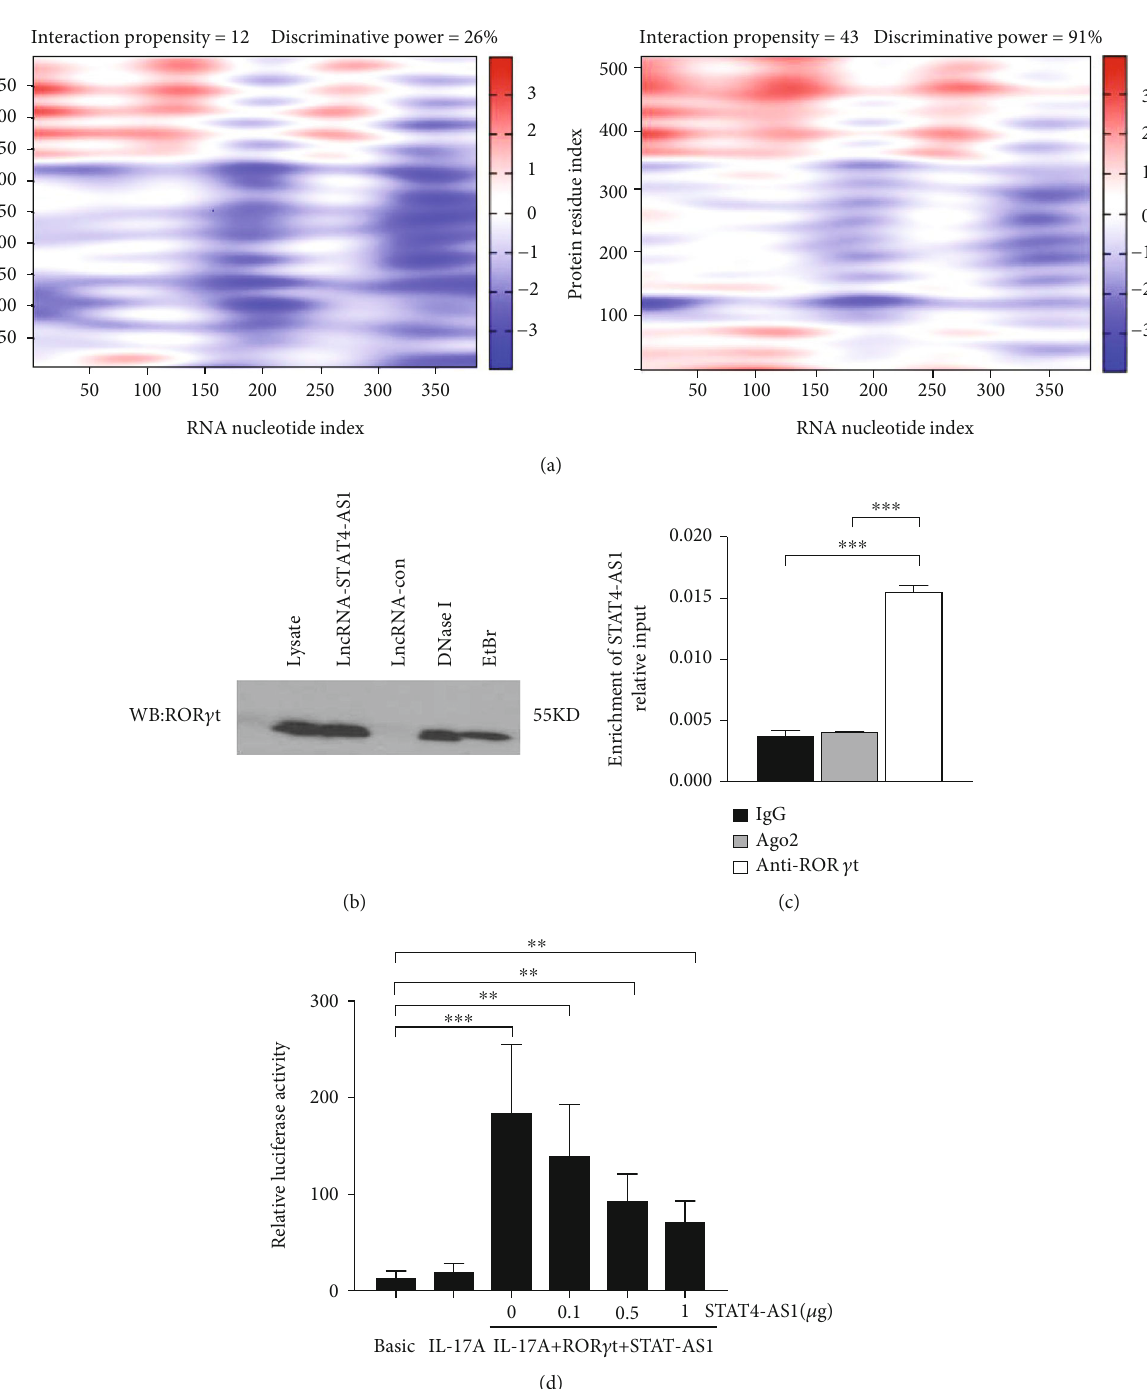
Figure 5: lncRNA STAT4-AS1 interacted with ROR γ t and inhibited IL-17 expression. (a) Bioinformatics analysis predicted results of the interaction between lncRNA STAT4-AS1 and ROR γ t protein. Left: the interaction between lncRNA STAT4-AS1 and ROR γ t protein. Right: the interaction between lncRNA STAT4-AS1 and ROR γ t protein isoform (ROR γ ). (b) ROR γ t protein was detected in the extracts of the RNA pull-down using Western blot. lncRNA-Con was used as negative control. (c) RT-qPCR detection of lncRNA STAT4-AS1 mRNA in the immunoprecipitation by IgG, AGO2 or anti-ROR γ t speci fi c antibody from PBMCs treated with TH17 polarization. IgG served as a negative control. (d) Dual luciferase reporter assay was used to con fi rm the inhibition of lncRNA STAT4-AS1 during ROR γ t- induced activation of the IL-17 promoter. Three independent experiments were performed, and data are presented as the mean ± SD . ∗ p < 0 : 05 , ∗∗ p < 0 : 01 , and ∗∗∗ p < 0 : 001